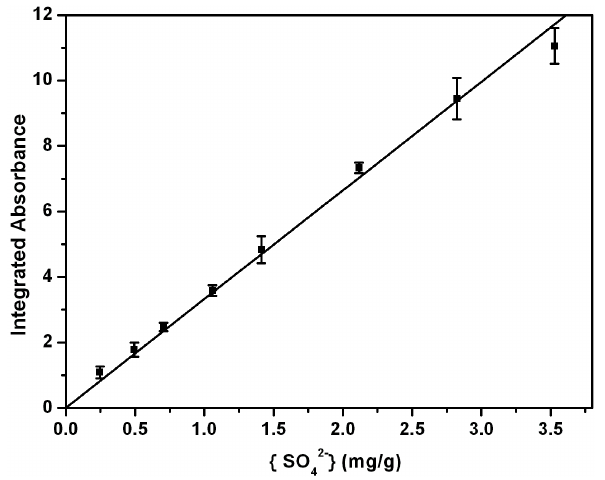
Fig. 4. Calibration curve for the integrated absorbance versus the concentration of sulfate.